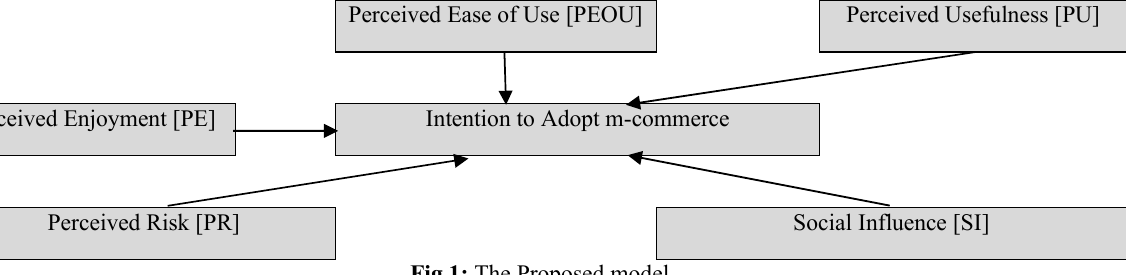
Fig 1: The Proposed